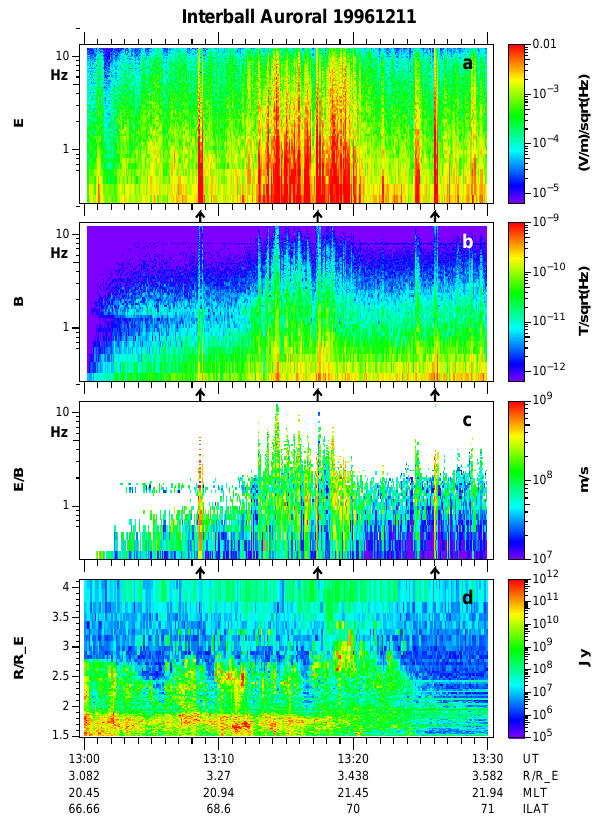
Fig. 11. Dot AKR example event 11 December 1996 with IESP and POLRAD data, showing (a) electric IESP wave amplitude, (b) mag- netic IESP wave power, (c) the E/B ratio from IESP and (d) POL- RAD AKR data. The vertical axis in panels (a)–(c) is Hz. The inten- sity in panel (d) is in Jansky (1Jy = 10 − 26 W m − 2 Hz − 1 ). The verti- cal axis in panel (d) is the radial distance corresponding to the AKR frequency, assuming the frequency corresponds to local electron gy- rofrequency. The dot AKR seen at 13:18–13:20 at ∼ 3 R E radial distance (45–70kHz) occurs simultaneously with electromagnetic low frequency wave activity. Dots at 13:01–13:02, 13:07–13:08 and 13:09–13:11 are not associated with low frequency